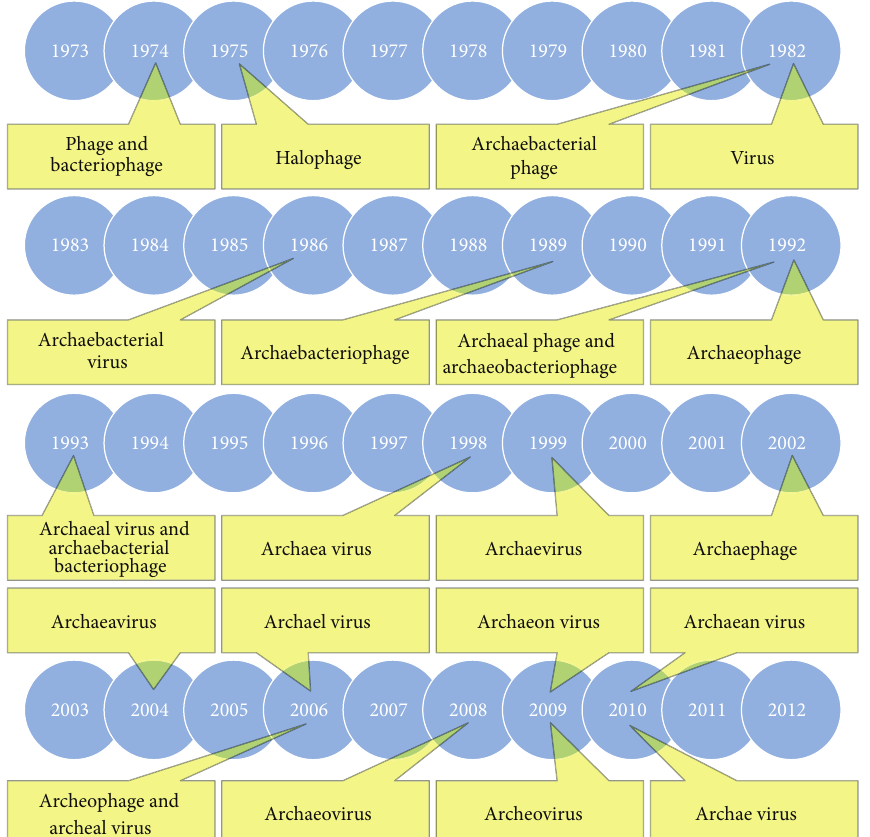
Figure 1: Various names that have been used to generally describe archaeal viruses as well as subsets of those viruses (e.g., “Halophage”). A sampling of those terms along with what to the best of our knowledge are their dates of introduction into the literature are presented in a timeline format. Note in particular the diversity as well as, even over the last decade, an apparently ongoing lack of consensus. References for first use, again to the best of our knowledge, are as follows: Bacteriophage (and Phage) [11], Halophage [12], Archaebacterial phage [13], Virus [13] (see, however, also [14]), Archaebacterial virus [15], Archaebacteriophage [16], Archaeobacteriophage [17], Archaeal